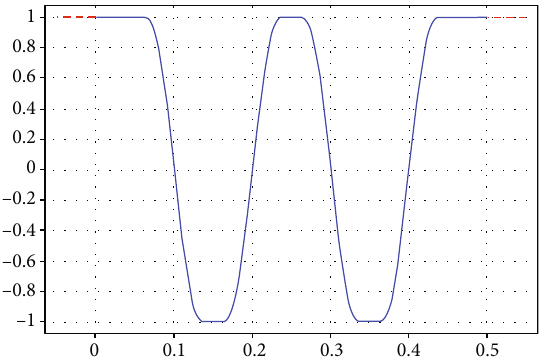
Figure 7: A unit piecewise function showing the same curve of input signal.